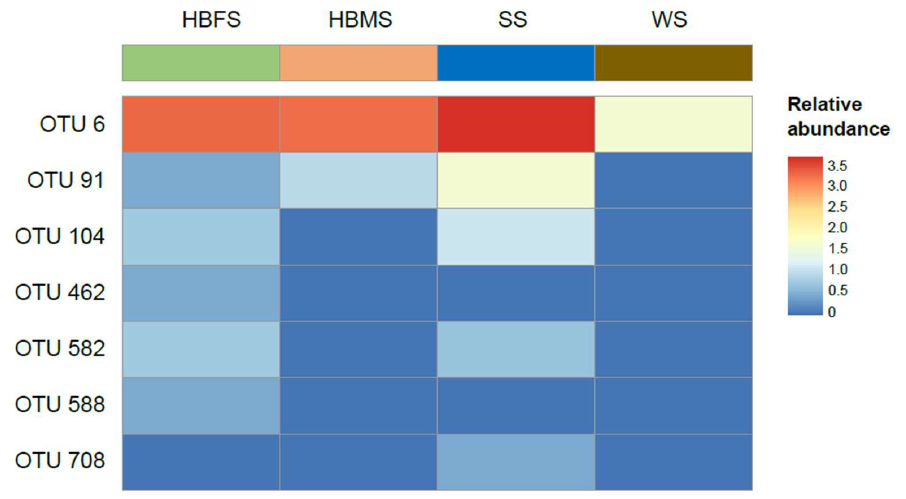
Figure 2. Heatmap of OTUs assigned to the Aeromonadaceae family, which were compared with their abundances in each sample. The color intensity (log2 scale) in each panel shows the percentage of each OTU.